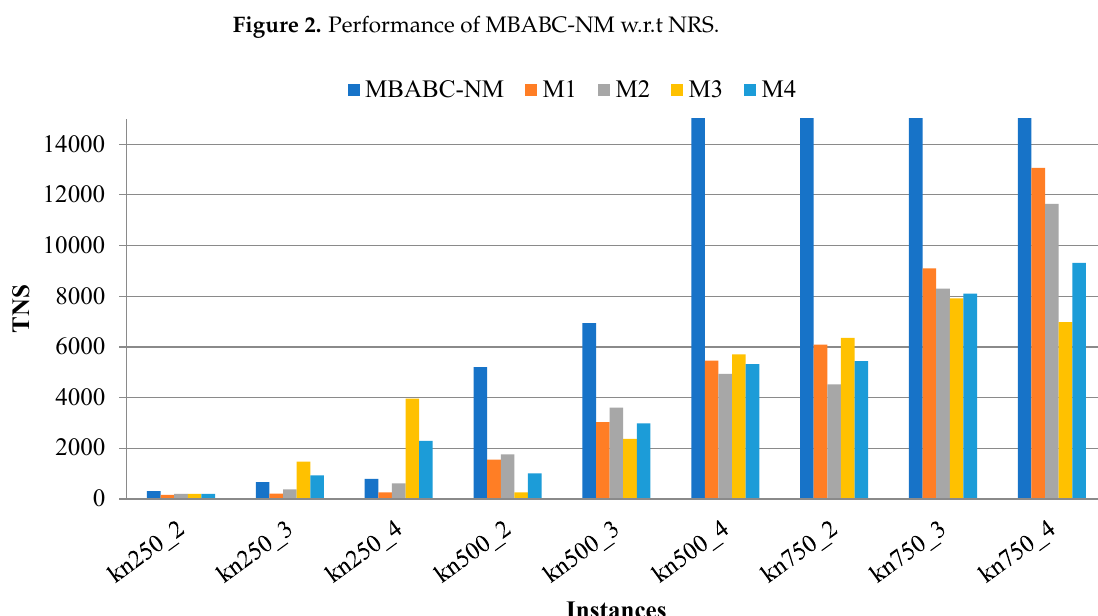
Figure 3. Performance of MBABC-NM with respect to TNS.